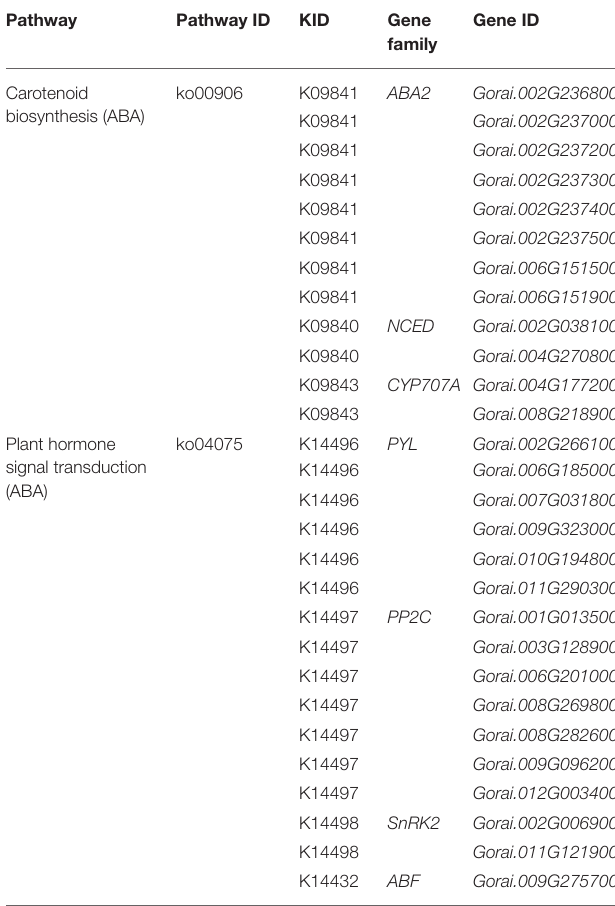
TABLE 2 | List of genes related to ABA biosynthesis and signal